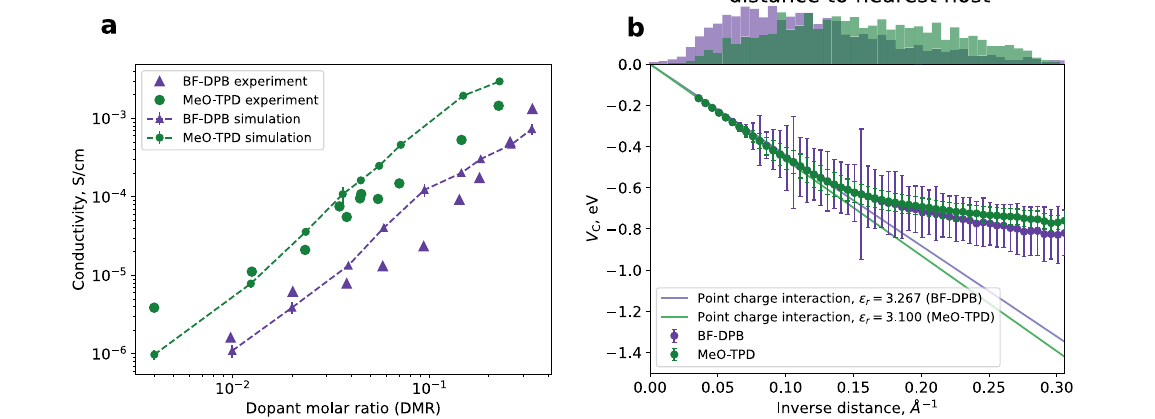
b Distance-dependentmeananddisorderof V C ( r )ofthemicroscopicmodel(points and error bars, respectively) in comparison to a screened monopole – monopole model (classical Coulomb interaction) show (i) a much larger disorder of V C ( r ) for BF-DPBincomparison toMeO-TPD, explaining thereducedconductivityin ( a )and (ii)areversaloftheorderof V C ( r